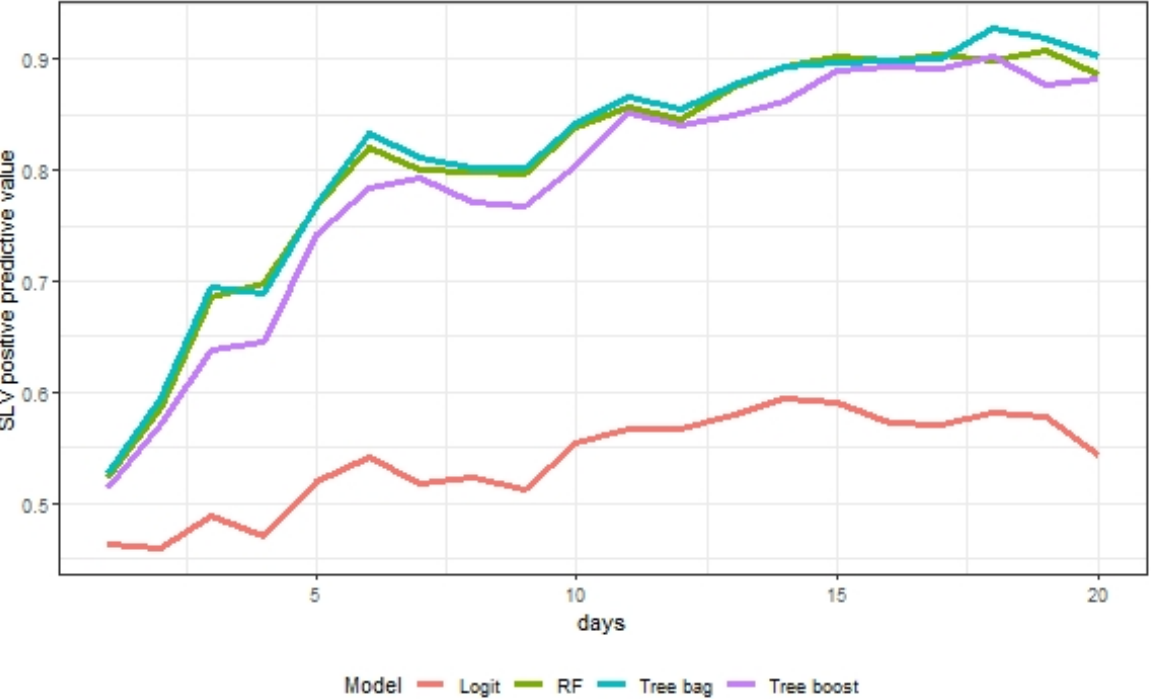
Figure 8. This figure shows the multi-period positive predictive values accuracy value for GLD price direction.